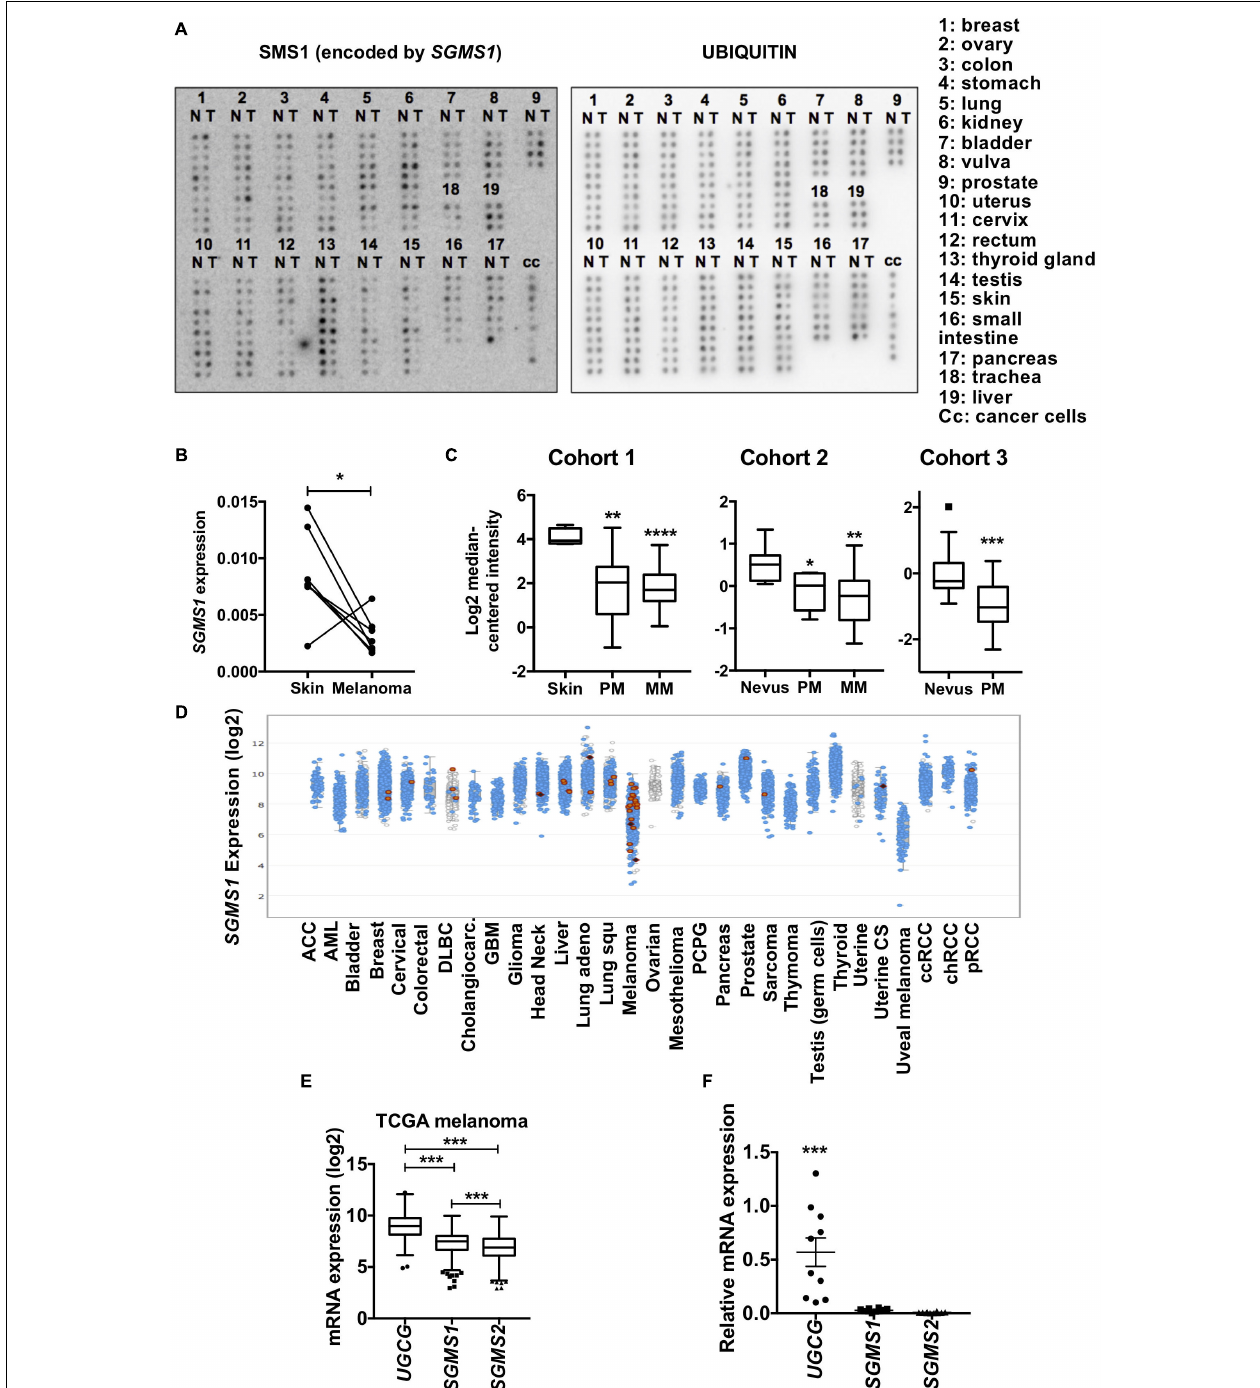
FIGURE 1 | Sphingomyelin synthase 1 (SMS1) is frequently downregulated in melanoma. (A) cDNA samples isolated from normal (N) and tumor (T) tissues from the same patient were compared. Expression of SGMS1 (left panel) and ubiquitin (right panel). (B) The SGMS1 expression was normalized to ubiquitin and expressed for each pair in normal skin and melanoma samples. (C) SGMS1 expression was analyzed in 3 different cohorts from Oncomine in normal Skin ( n = 4), primary (PM; n = 14), and metastatic (MM; n = 39) melanoma (Ricker’s cohort) (left panel); in nevus ( n = 9), primary (PM; n = 6), and metastatic (MM; n = 19) melanoma (Haqq’s cohort) (middle panel); in nevus ( n = 18) and primary melanoma (PM; n = 45) (Talantov’s cohort) (right panel). (D) The expression of SGMS1 was analyzed in various cancer type cohorts from cbioportal. (E) The expression of UGCG , SGMS1 , and SGMS2 was analyzed in melanoma samples from the TCGA metastatic melanoma patients ( n = 342). (F) A set of melanoma cell lines ( n = 10) was analyzed for the expression of UGCG , SGMS1 , and SGMS2 by RT-qPCR ( n = 10). Data from at least two independent experiments are means ± SEM. ∗ p < 0.05, ∗∗ p < 0.01, ∗∗∗ p < 0.001, and ∗∗∗ p < 0.0001.